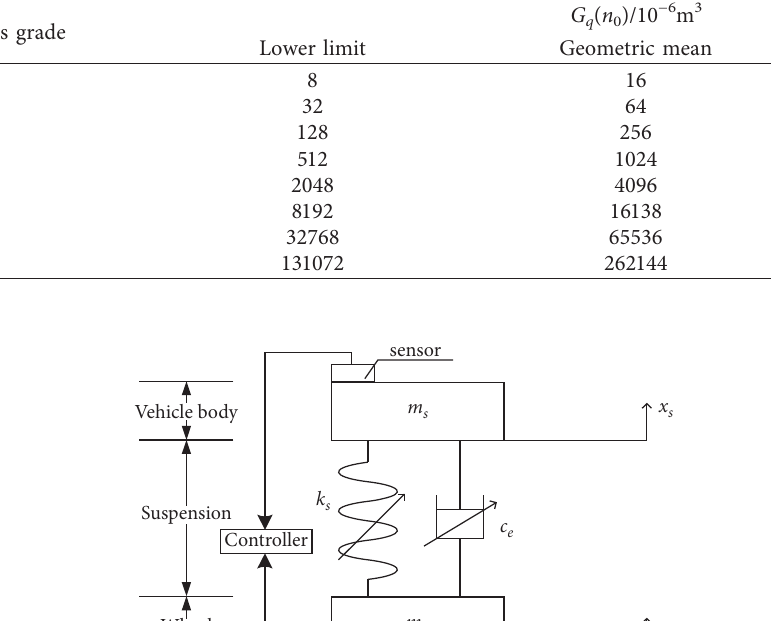
Table 1: Classification criteria for unevenness of road surface.